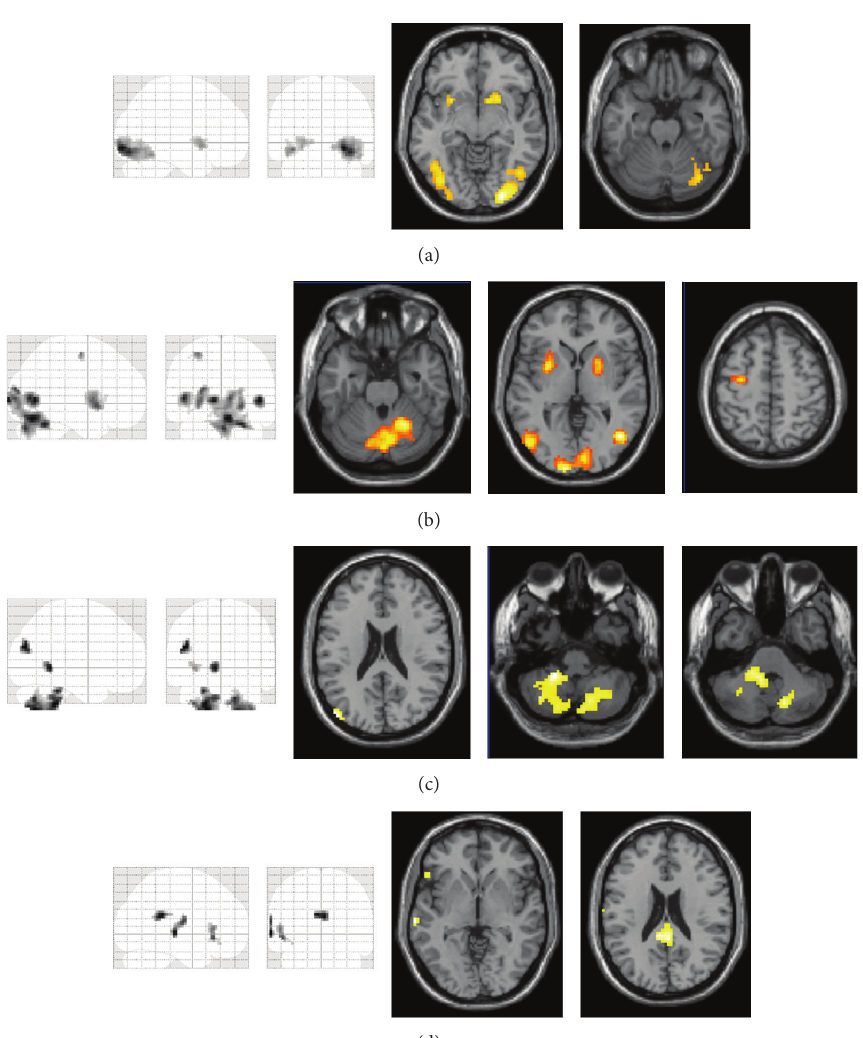
Figure 3: Results of the 3 × 2 ANOVA ( 𝑝 < 0.05 , FWE-corrected at the whole brain level): (a) main effect hit versus miss (hit-miss) (threshold 𝑇 = 4.56 ). (b) Main effect of speed ( 𝐹 -contrast) (threshold 𝐹 = 13.36 ). (c) Female > male (threshold 𝑇 = 4.56 ). (d) Male > female (threshold 𝑇 = 4.56 ). Radiological conventions for the laterality were used where the right side in the figure corresponds to the right side in the scanned area and vice